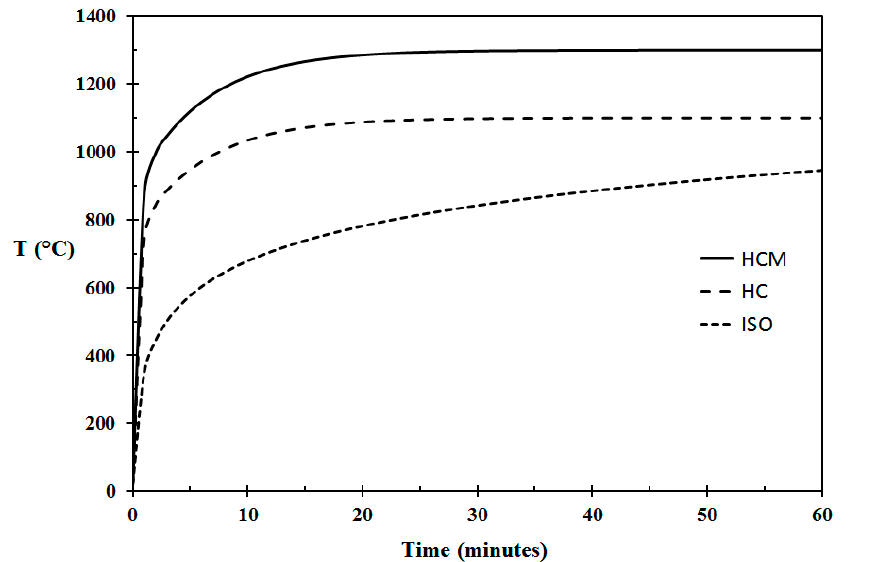
Figure 1. Fire testing temperature time curves.